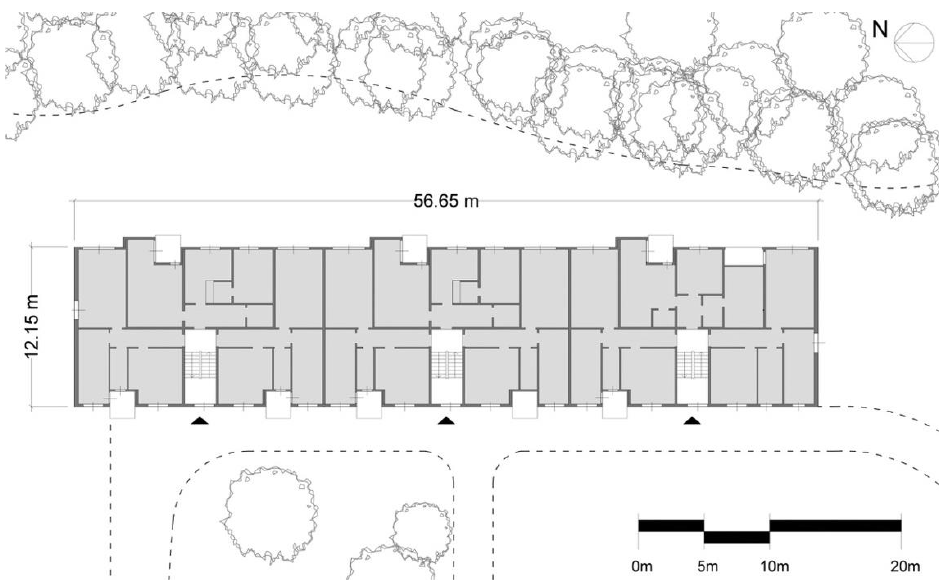
Figure 1. Floor plan of the considered building with typical context.